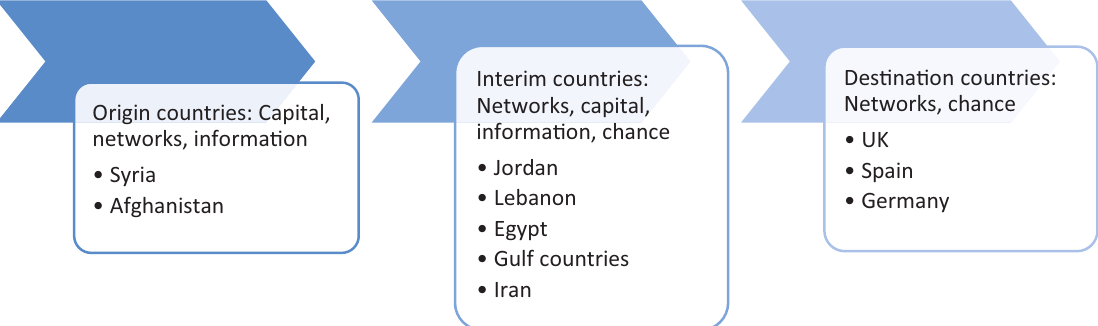
Figure 1. Key aspects of participants’ migration trajectories from point of departure to “final”